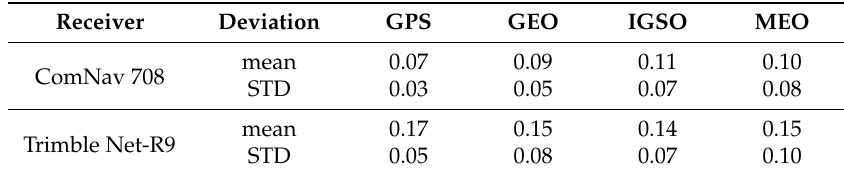
Table 1. Statistical results of the C/A and B1 code precision of different types of satellite observations (m). GPS = global positioning system; GEO = geostationary orbit; IGSO = inclined geosynchronous orbit; MEO = medium-altitude Earth orbit; STD = standard